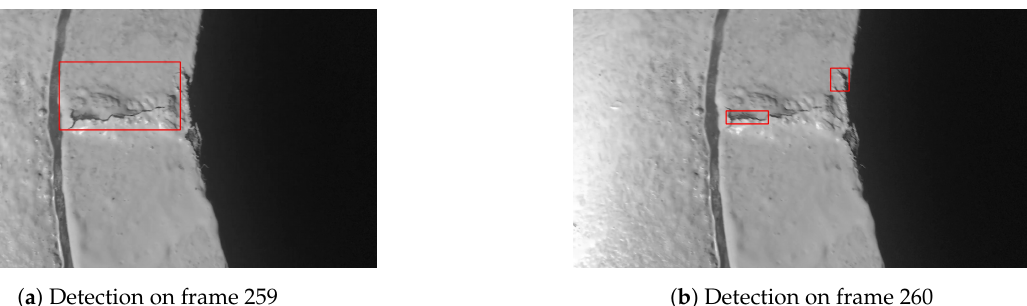
Figure 4. Scale of detection bounding boxes varies significantly on the consecutive